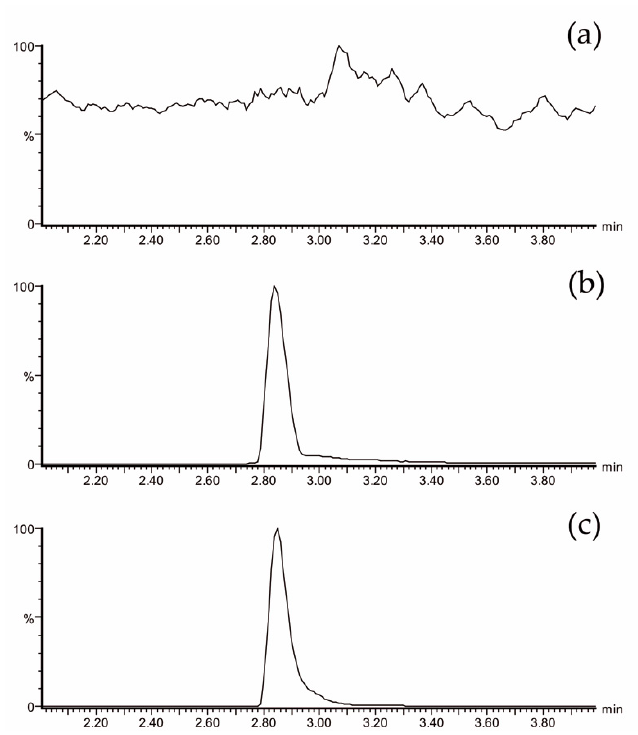
Figure 2. LC-MS/MS chromatogram of EGCG showing the most specific and sensitive MS/MS transition m/z 457 → 169: ( a ) plasma sample from a volunteer at baseline, ( b ) blank of plasma spiked with 428 ng/mL of EGCG, and ( c ) plasma sample from a volunteer at 60 min after Teavigo ® ingestion (calculated concentration: 289 ng/mL). LC-MS/MS = liquid chromatography tandem mass spectrometry.